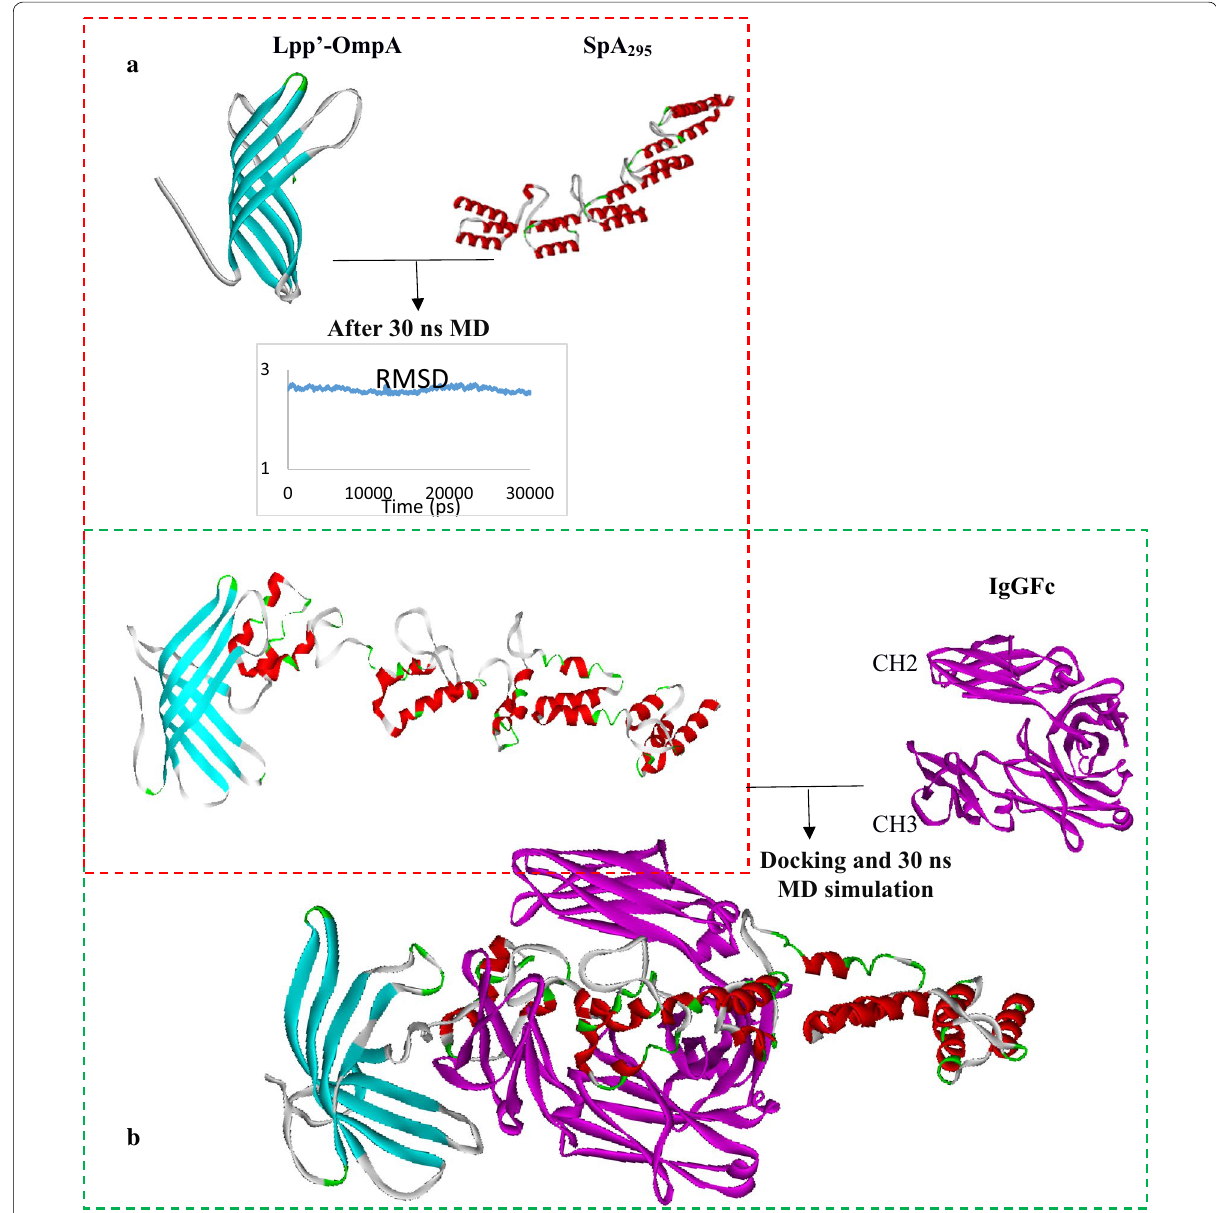
Fig. 2 a The primary structure of Lpp’-OmpA, SpA 295 and its complex after 30 ns molecular dynamics, RMSD plot of protein structure compared to the primary structure. b Lpp ′ -OmpA-Spa 295 - and IgG FC and their cpmlex after docking and 30 ns molecular dynamics